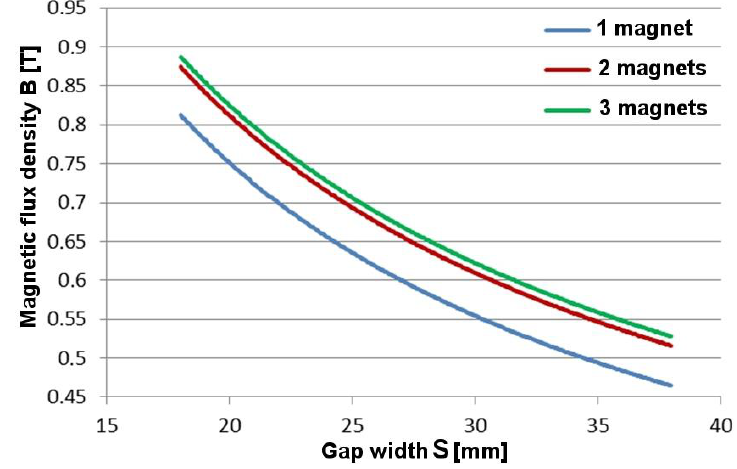
Figure 11. Impact on the magnetic flux density in the center of the machining gap area depending on the machining gap width and number of magnets, obtained from simulation.